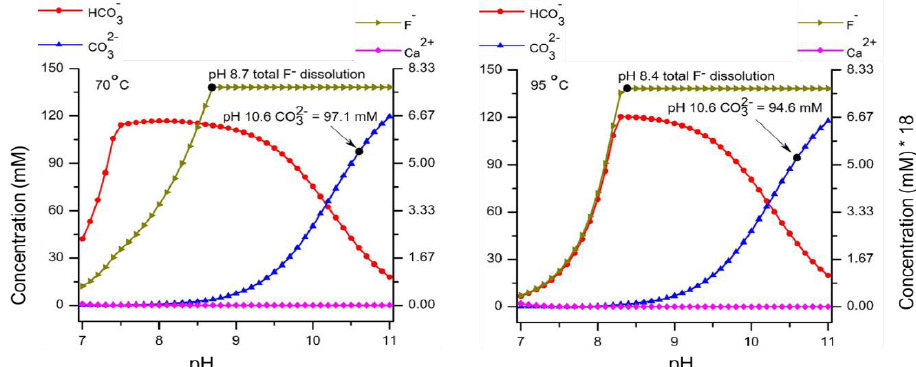
Figure A1. Thermodynamic calculation with 150mM Na 2 CO 3 and 300 mg/L CaF 2 from pH range 7–11 and temperature (70 and 95 °C).